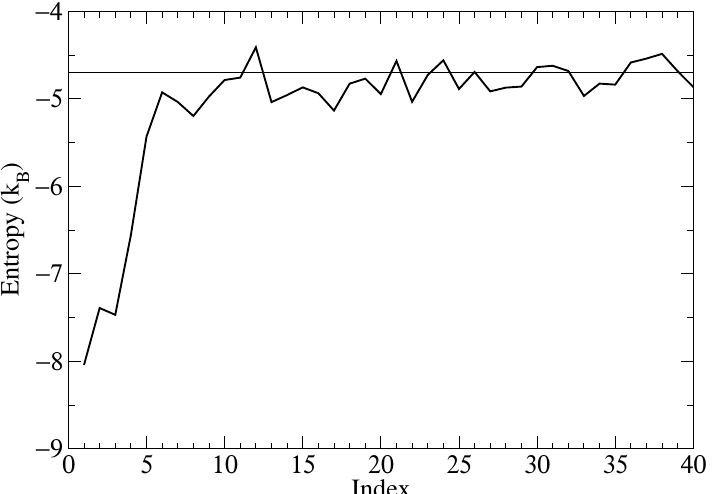
Figure 6. The entropy of the relabeled molecules (continuous line) indexed based on the distance from the fixed molecule. The entropy corresponding to the non-interacting symmetric molecules is shown by the broken